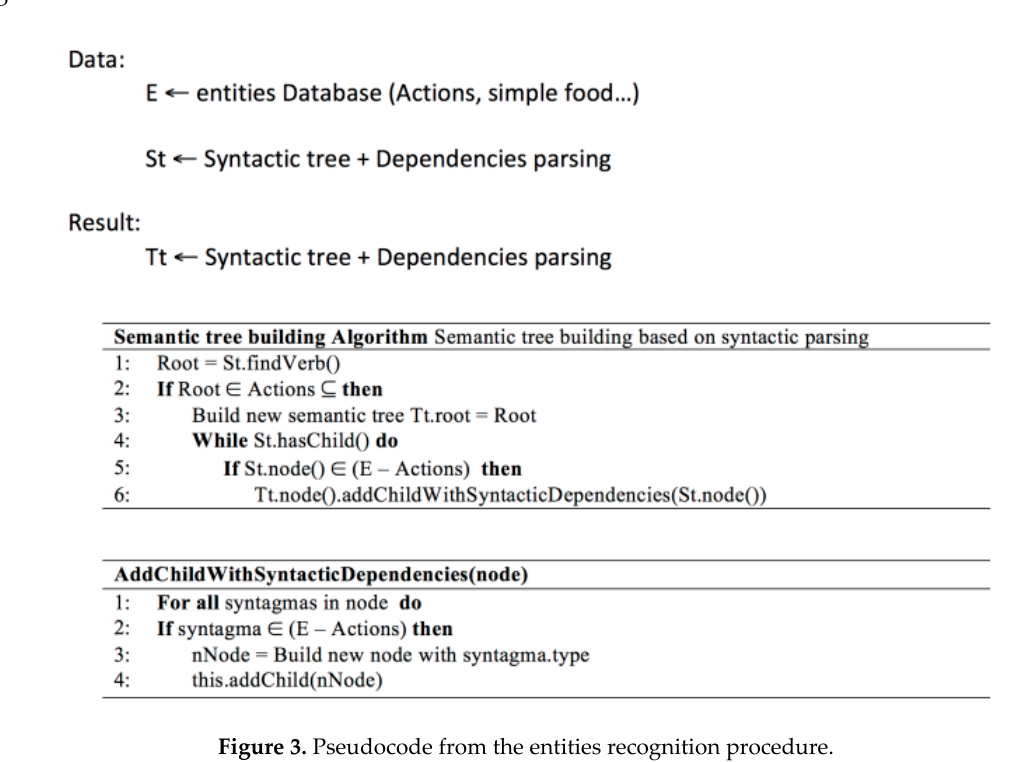
Figure 3. Pseudocode from the entities recognition